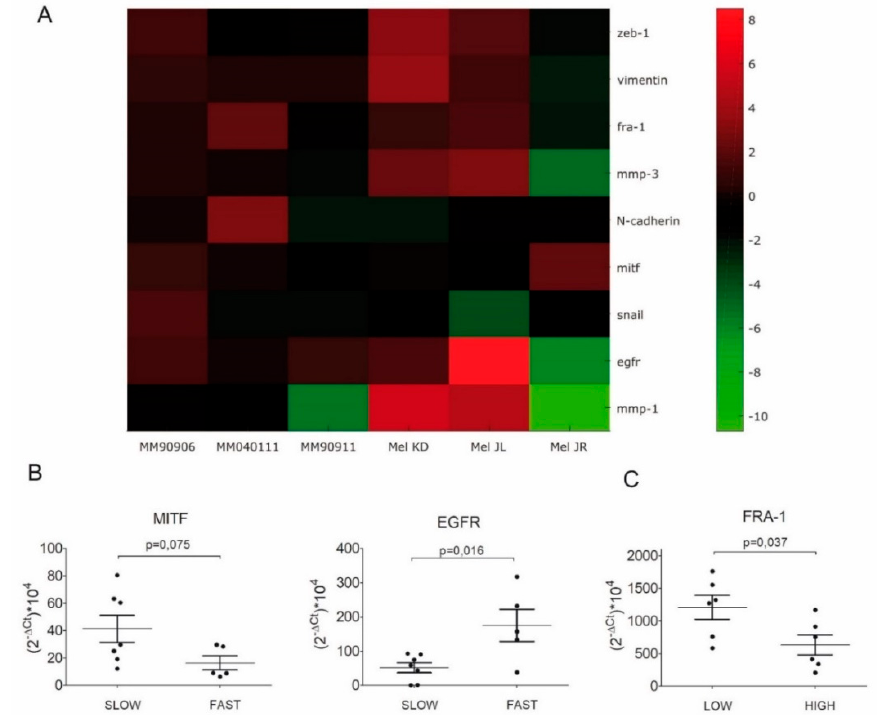
Figure 2. mRNA expression of EMT markers, MITF, FRA-1, and EGFR of cell line pairs. ( A ) Heatmap of mRNA expression. Green indicates repressed mRNA levels and red elevated levels. GAPDH was used as housekeeping gene. ( B ) In fast migrating cells, there was considerably lower ( p = 0.075) MITF and significantly higher ( p = 0.016) EGFR mRNA expression. Cut-off value was 50 µm displacement in 20 h for dichotomizing slow and fast migrating cell lines. ( C ) Significantly lower ( p = 0.037) FRA-1 mRNA expression was measured in highly proliferating cells.